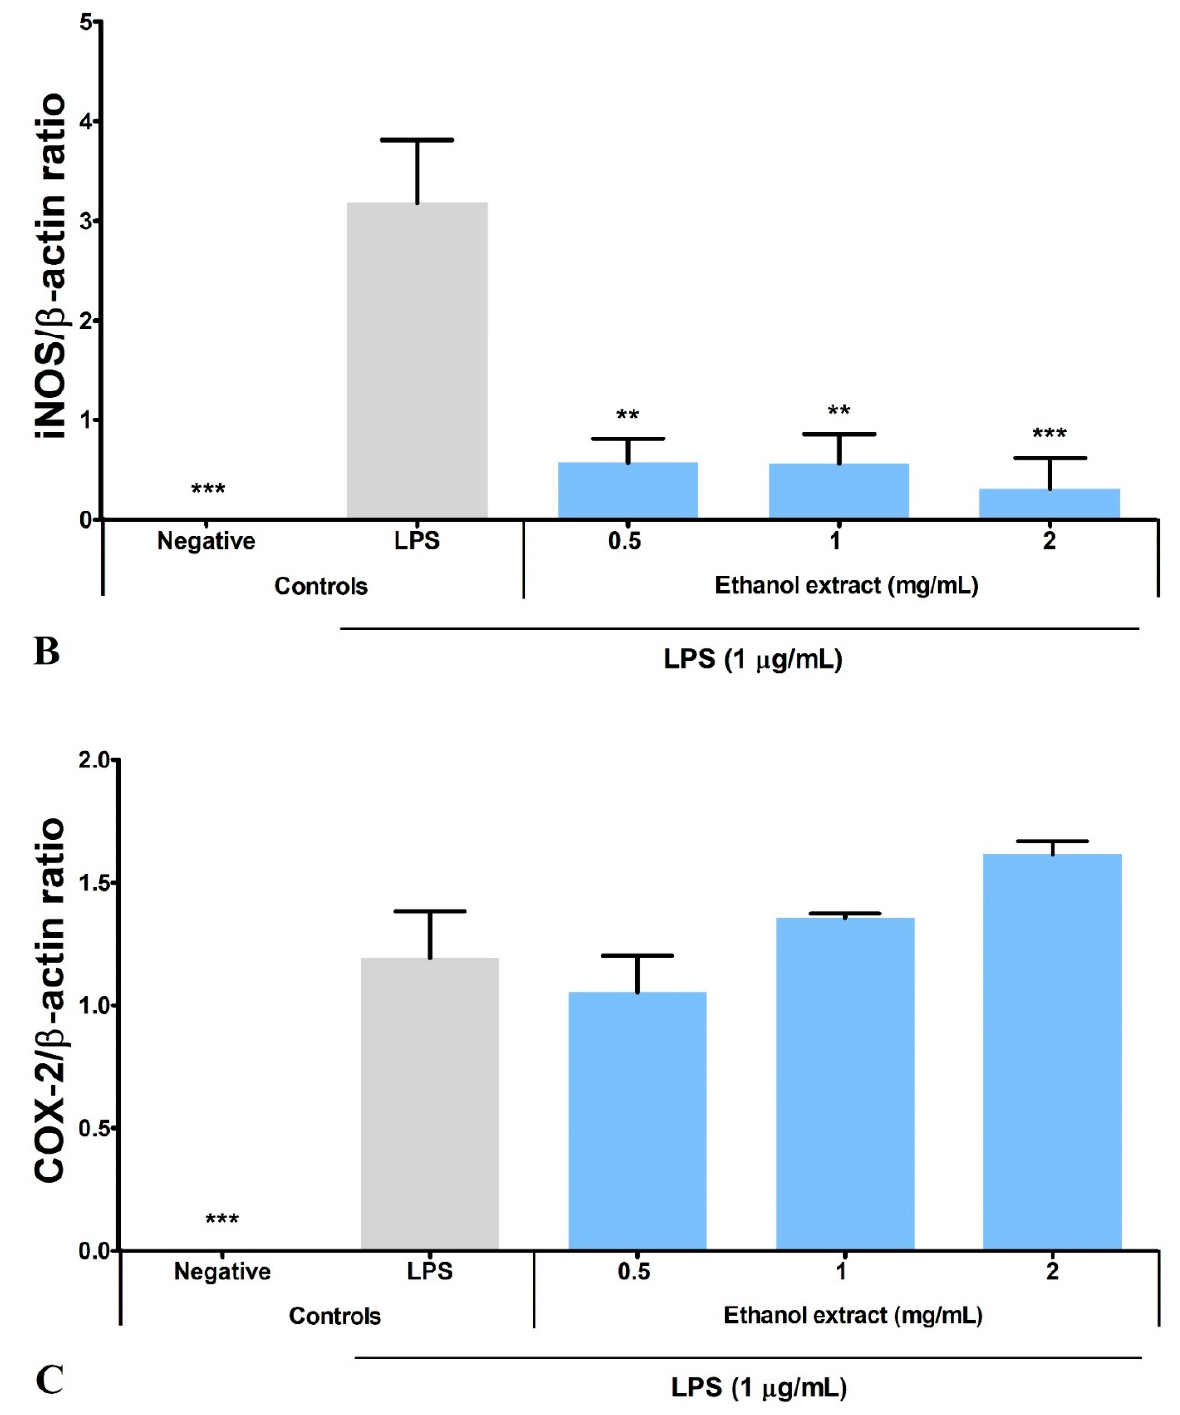
Figure 5. Regulation by S. platensis ethanol extract on the expression of the proinflammatory enzymes in LPS-induced BV2 microglia. Dose-dependent effects were observed on ( A ) iNOS and COX-2 protein expression. The blot shown was the representative results of three independent experiments. β -actin served as an internal control. ( B , C ) Quantification of relative band intensities from three independent experimental results was determined by densitometry. *** p ≤ 0.001 and ** p ≤ 0.01 significant difference in protein expression relative to LPS control by Dunnett’s multiple comparison test.